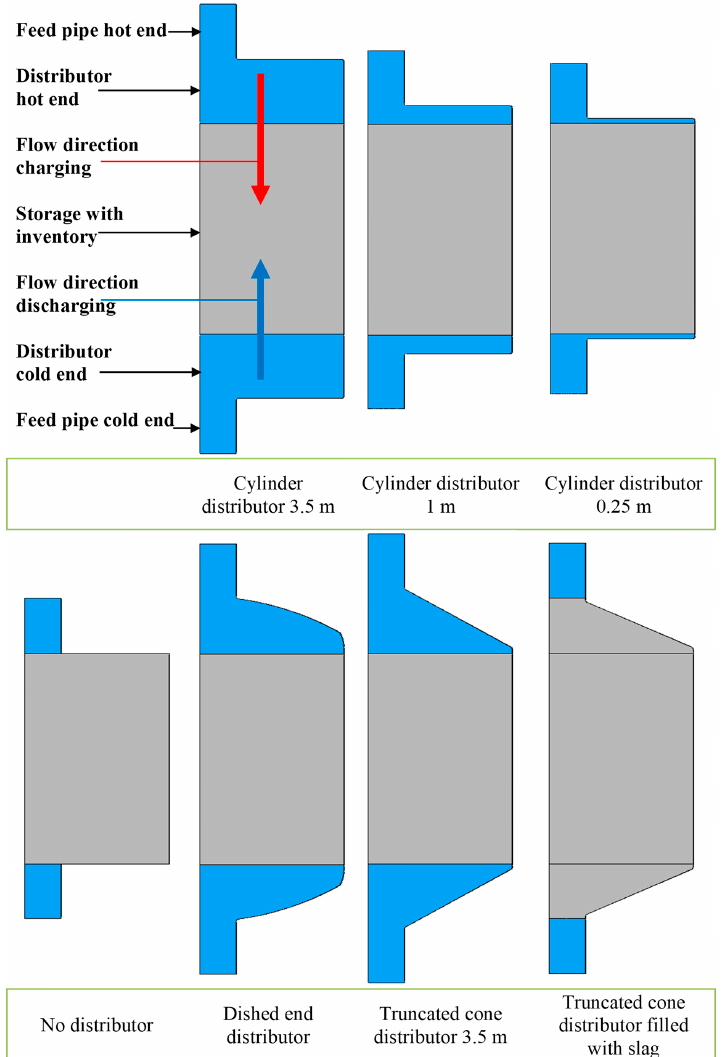
Figure 9. Different design options for the distributor. Figure 9. Di ff erent design options for the